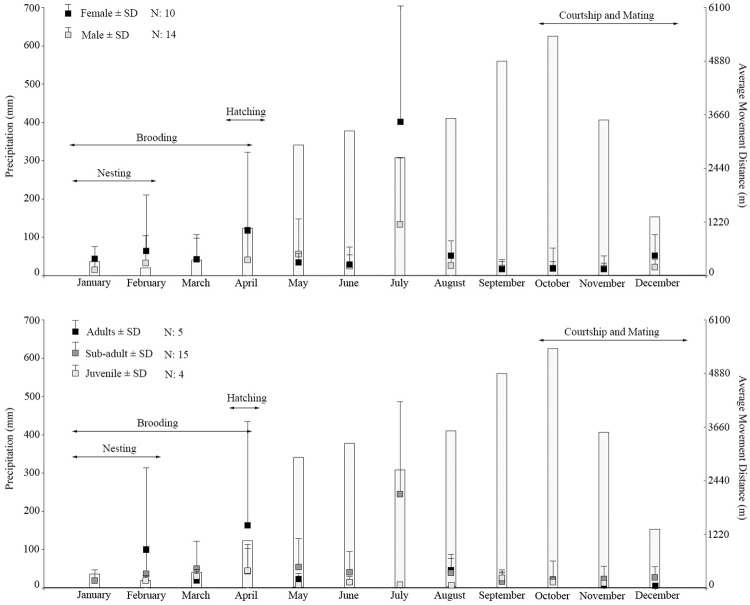
Average movement distances by sex and age group and the average precipitation.Average movement distances (AMD) per sex and age group of the American crocodile in Coiba Island related to average historical precipitation and reproductive ecology. Changes in AMD between seasons are clearer in females, adults, and sub-adults.